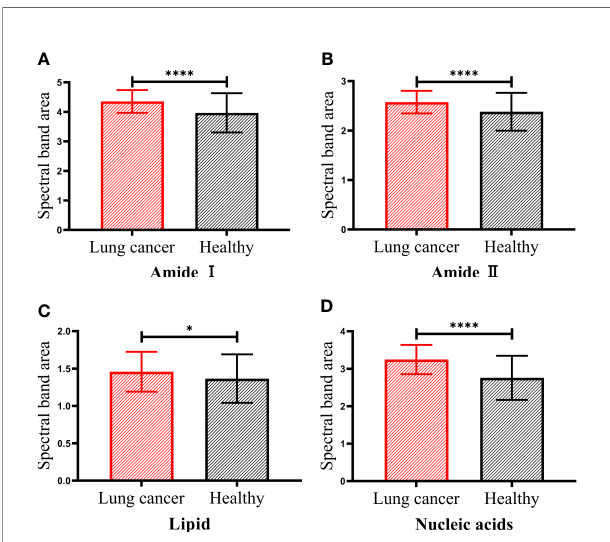
FIGURE 3 | The spectral band area of patients with lung cancer and healthy people. Amide I protein (1700-1600cm − 1 ) band (A) , Amide II protein (1560- 1500cm − 1 ) band (B) , lipid (3000-2800cm − 1 ) band (C) and nucleic acids (1250-1000cm − 1 ) band (D) . The statistical signi fi cance was signi fi ed as less than or equal to p < 0.05* and p < 0.0001****.